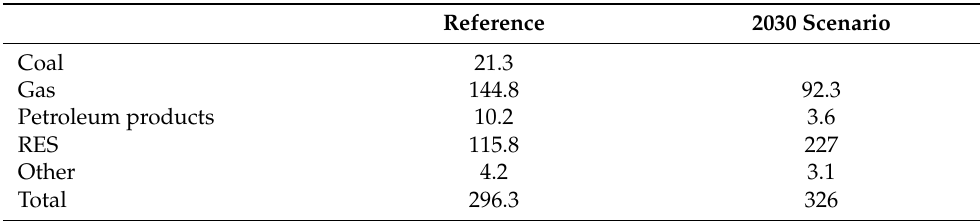
Table 5. Mix of total electric energy generation (TWh).